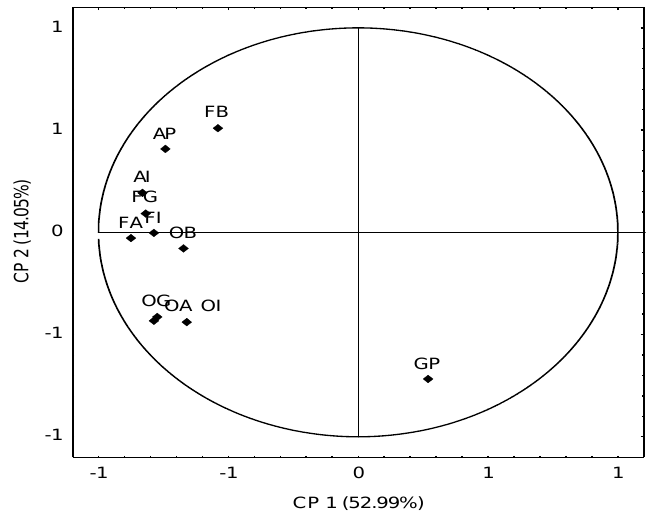
Figure 1. Principal component analysis of milk from goats of the Alpine breed subjected to treatments with increasing levels of total dissolved solids over a period of 48 days of exposure. Legend: FB= butter/rancid flavor; AP= aftertaste per- sistence; AI= aftertaste intensity; FG= goat flavor; FI= overall flavor intensity; FA= aromatic flavor; OB= butter/rancid odor; OG= goat odor; OA= aromatic odor; OI= overall odor intensity; GP= global persistence. The results of the sensorial analysis are described and represented as vectors, which correspond to the tasters and characterize the attributes that are located close to them. When evaluating the matrix, three different behaviors were observed: an isolated varia- ble and two clusters, each forming variables that followed the same trends. A group was formed by attributes that had the same trend: overall intensity of flavor (FI), aromatic flavor (FA), aftertaste persistence (AP) and aftertaste intensity (AI); however, these at- tributes were in the negative quadrant, indicating that this group obtained lower scores compared to the scores attributed to the other groups, thus demonstrating the negative responses by the testers of these variables. When correlated with the other attributes, this group was in contrast to the overall appearance (GP), which means that there was a negative correlation between them; that is, there was a negative association according to the tasters between the overall appearance. However, as higher grades were attributed to flavor and aftertaste, lower grades were attributed to overall appearance. There was a positive correlation between the groups formed by the attributes of butter/rancid odor (OB), aromatic odor (OA), goat milk odor (OG) and overall odor intensity (OI) because this group was in the positive quadrant, demonstrating the acceptance by the tasters of these variables. However, as these characteristics moved away from the abscissa, they were less correlated with overall assessment.